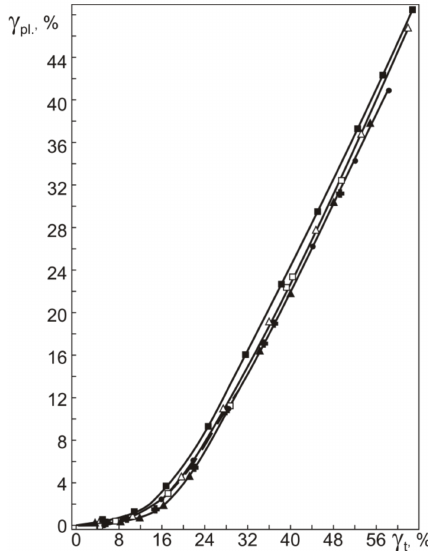
Figure 5. Plastic strain γ pl vs. total strain γ t in torsion at 295 K for Ti 49.8 Ni 50.2 before ( (cid:8) ) and after abc pressing with e equal to 0.6 ( (cid:4) ), 1.8 ( (cid:52) ), 4.2 ( (cid:3) ), 6.4 ( ), and 8.4 ( (cid:78) ).